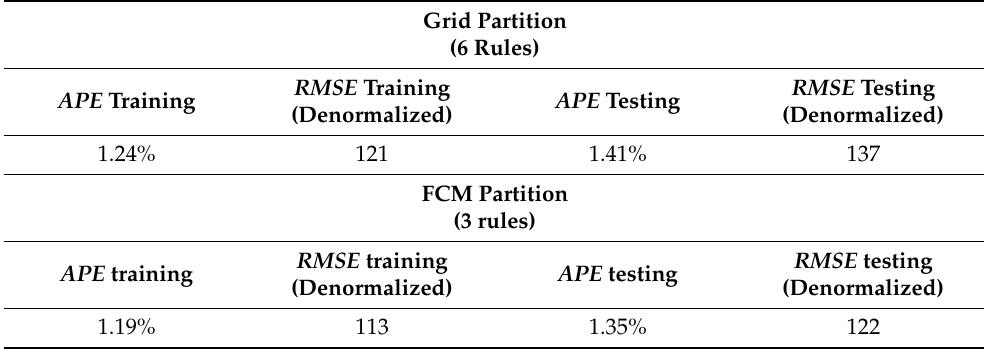
Table 3. Yearly APE and RMSE .